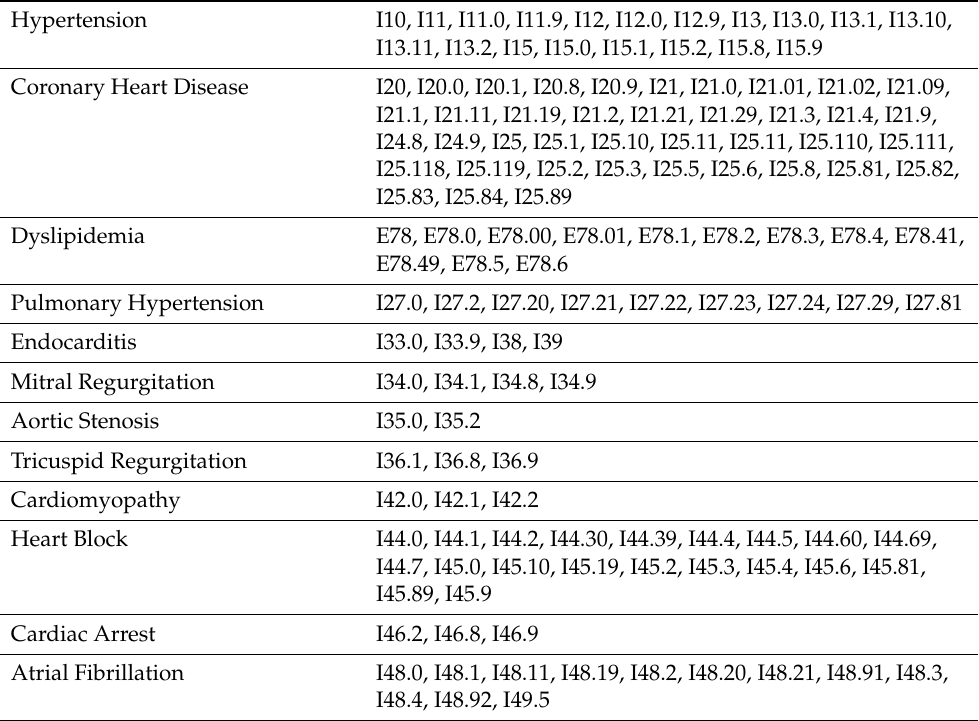
Table A1. ICD-10 code used to define